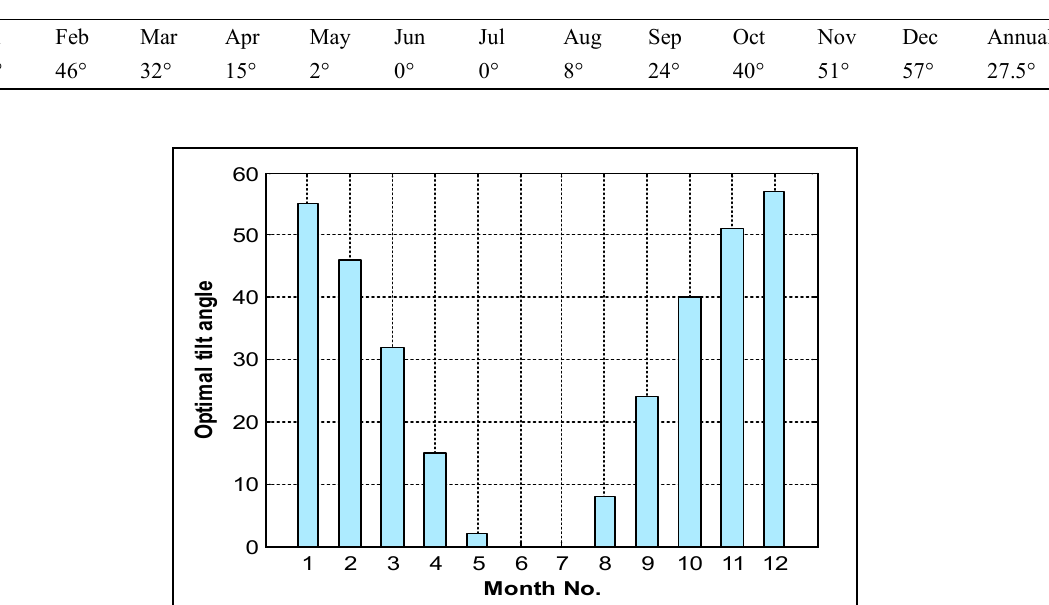
Figure 16. Monthly optimal tilt angle using MATLAB for New Delhi.